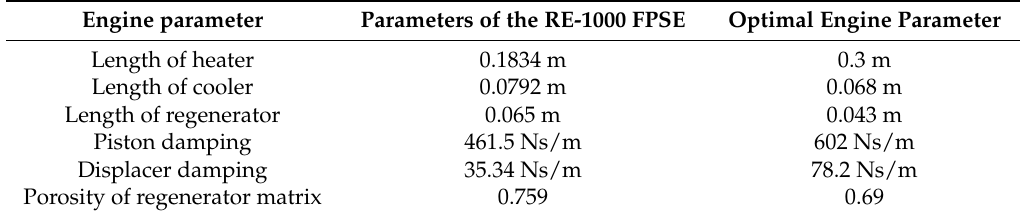
Table 6. The design parameters obtained from GA optimisation procedure.